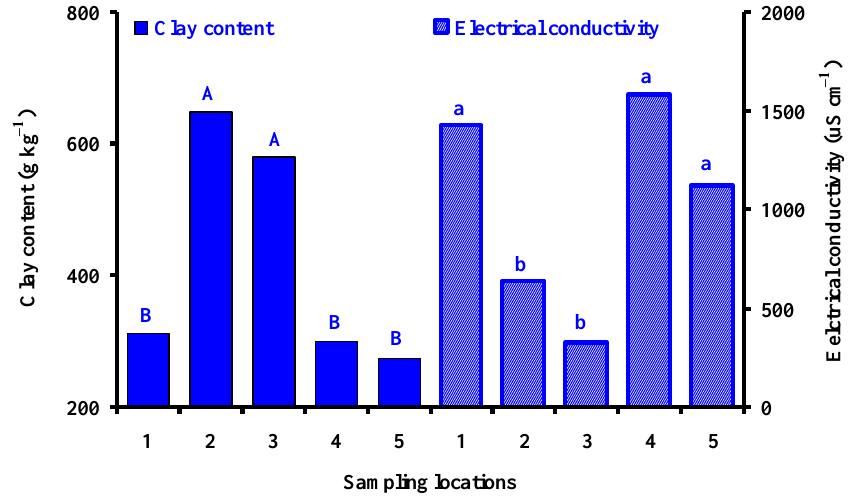
Figure 3. Effect of sampling locations on clay content and electrical conductivity of soil samples collected from locations 1 through 5 across the watershed. Tukey’s mean separation results are shown by the different letters, i.e. , the two groups with two different letters were statistically